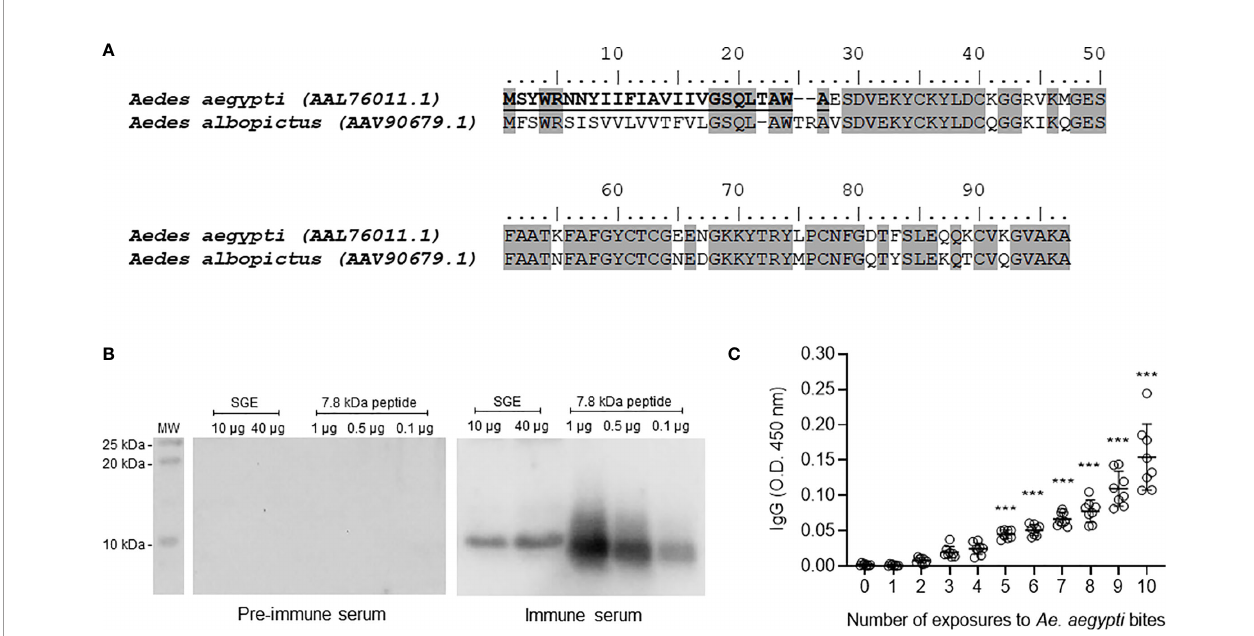
FIGURE 1 | Ae. aegypti 7.8 kDa peptide is secreted in the mosquito saliva and triggers the production of speci fi c antibodies following exposure to mosquitoes. (A) Amino acid sequence and alignment of Ae. aegypti (Accession number AAL76011.1) and Ae. albopictus (Accession number AAV90679.1) 7.8 kDa salivary peptides. The alignment was performed using MUSCLE method and graphically edited using BioEdit software. Gray highlights the identical amino acid residues (68% identity) and bold underlined amino acid residues indicate the signal peptide. (B) Ae. aegypti salivary gland extract (SGE - 10 and 40 µg) and 7.8 kDa salivary peptide (0.1, 0.5 and 1 µg) were submitted to electrophoresis on a 15% polyacrylamide gel under reducing conditions. Western blot was performed according to Material and Methods to test the reactivity of pre-immune and immune serum. The immunoreactive bands were revealed with luminescence substrate and acquired by an imaging system. (C) Sera of mice repeatedly exposed to female Ae. aegypti bites recognize the salivary peptide. Plates were coated with the salivary peptide (0.5 µg/ well), incubated with serum from animals exposed 0 to 10 times to female mosquito bites (1:100 dilution) and then with secondary antibody anti-mouse IgG conjugated with HRP. The plates were revealed after substrate addition and read in a spectrophotometer at a 450 nm wavelength. White circles in (C) indicate individual sera for each exposure (n = 8). The mean ± SEM are indicated. *** P ≤ 0.001 versus group “ 0 ” (not exposed to mosquito bites) – One-way